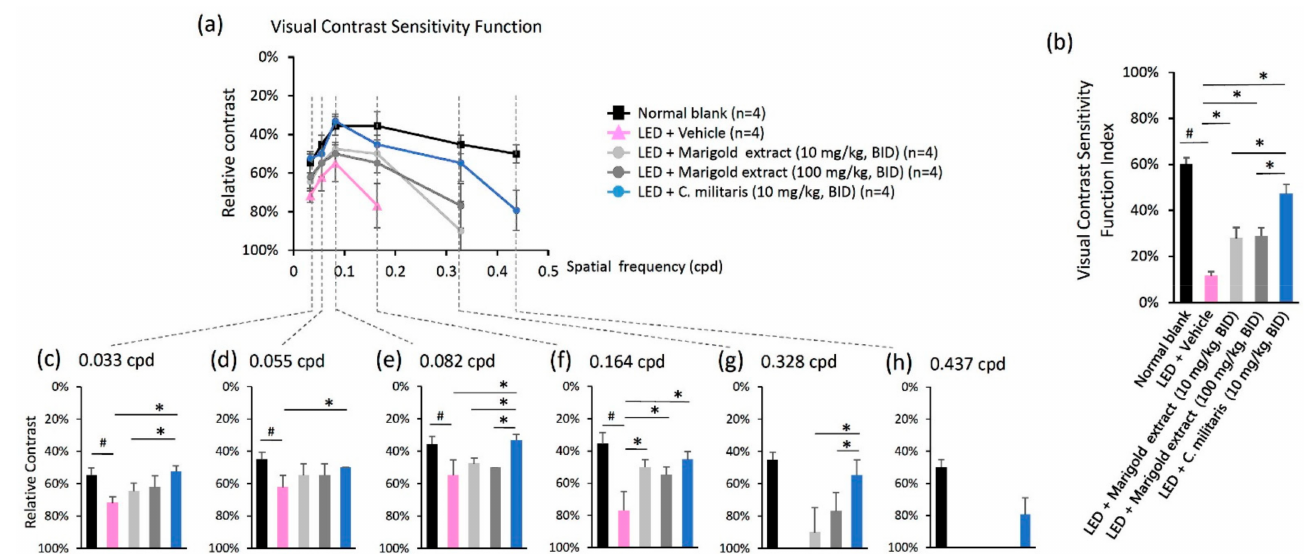
Figure 4. Effects on visual contrast sensitivity function (VCSF) of C. militaris extract treatment. ( a ) The inverted U-shaped diagram of the VCSF curve; ( b ) The VCSF visibility index; ( c ) The individual threshold with details represented in 0.033 cpd, ( d ) 0.055 cpd, ( e ) 0.082 cpd, ( f ) 0.164 cpd, ( g ) 0.328 cpd, and ( h ) 0.437 cpd. Data are expressed as mean ± SE. A Mann-Whitney U test was performed. # : p < 0.05, *: p <